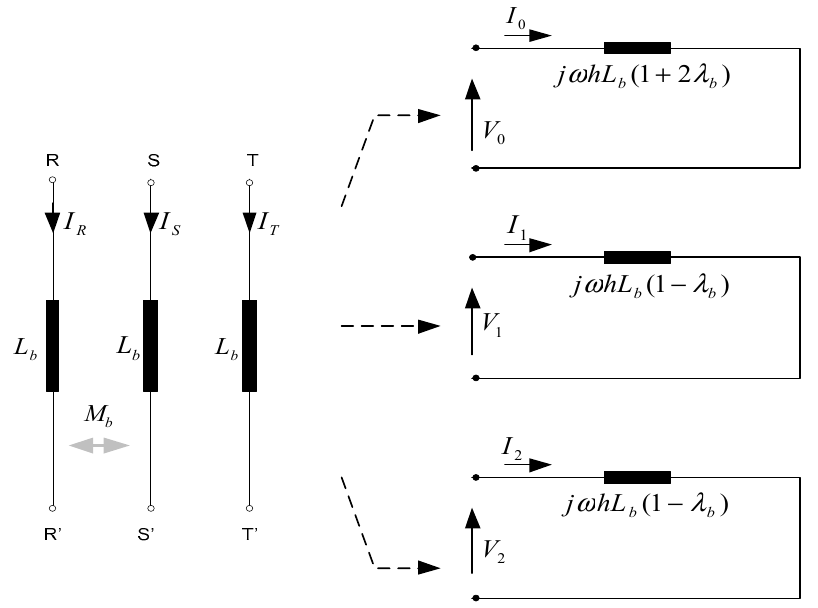
Figure 2. Blocker decoupled sequential circuits. These characteristics reveal the blocking action to zero-sequence components, the ef- fectiveness of which is proportional to the coupling factor, which is ideally of unitary value. In the ZSF, as the mutual inductance value between the main and auxiliary coils of the same column, M f , approaches the value of the coils’ self-inductance, L f , the zero-sequence equivalent inductance tends to be the minimum value. Ideally, these inductances are related, as shown in Equation